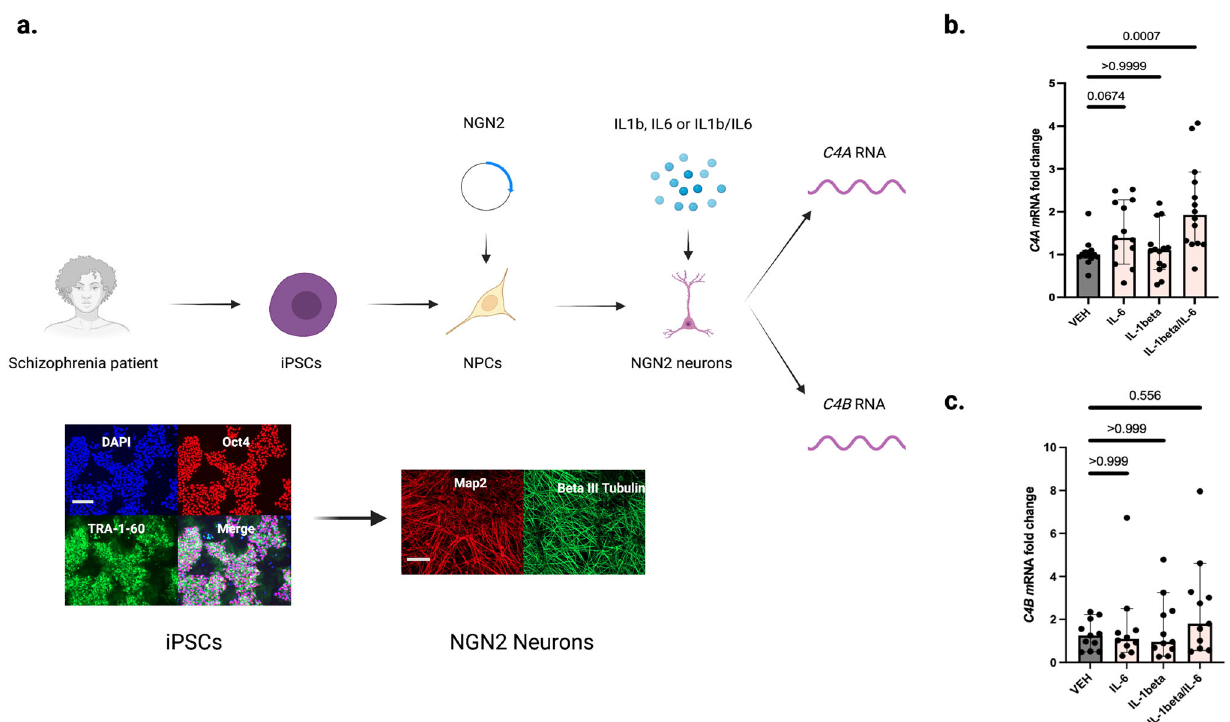
Fig. 2 | Disease-associated cytokines increase neuronal C4A mRNA expression in a patient derived schizophrenia model. a Overview of in vitro experiments in whichinduced pluripotent stem cells(iPSCs)derived from four chronic patients (all white males, 28- years old, 44-years old, 55-years old, and 58-years old, respectively) were differentiated into cortical excitatory neurons. Representative quality control immunocytochemistry images display octamer binding transcription factor 4 (POU domain,class5,transcriptionfactor1)andTRA-1 – 60,aswellasnuclearstainingwith DAPIforiPSCsthatwereusedtoderivecorticalexcitatoryneurons(herestainedfor MAP2andBetaIIITubulin).Scalebarsforrepresentativeimages:100uM. b qPCRwas used to measure relative mRNA expression of C4A . The relative C4A mRNA expres- sion increased signi fi cantly after pre-treatment for 24h with the interleukin (IL) − 1beta and IL-6 combination (median fold change=1.9, 95% con fi dence interval [CI]=1.5 – 2.7)comparedtovehicle(VEH)stimulatedneuronalcultures(median=1.0, CI=0.86 – 1.2, adjusted P =0.0007), while the increase in relative mRNA expression was not signi fi cant after IL-1beta (median=1.1, CI=0.79 – 1.5, adjusted P =0.999) or